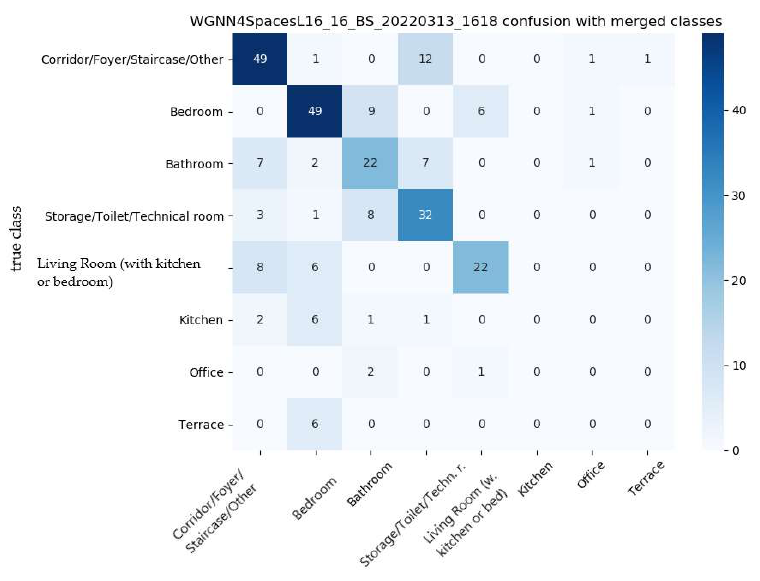
Figure 6. Confusion Matrix of the WGN classification with layer size of two, after merging classes. The accuracy reached 64%.